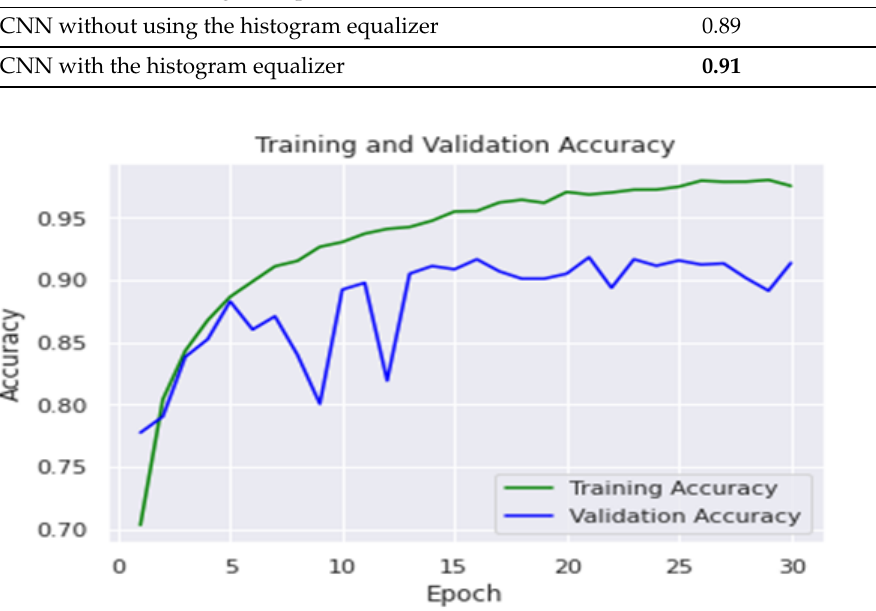
Figure 11. Training and validation accuracy for